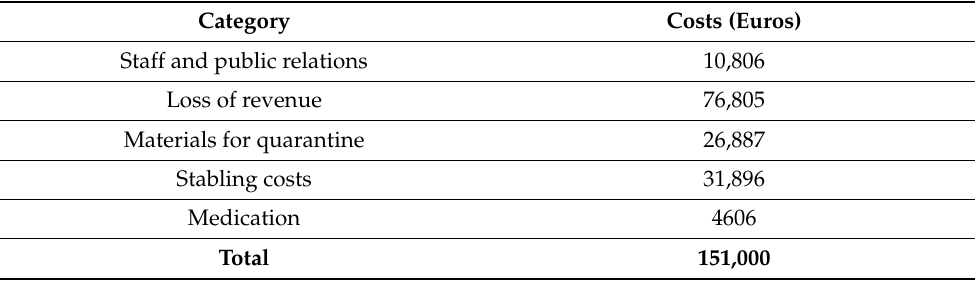
Table 3. All costs incurred by the hospital, divided into five categories, presented in euros ( €